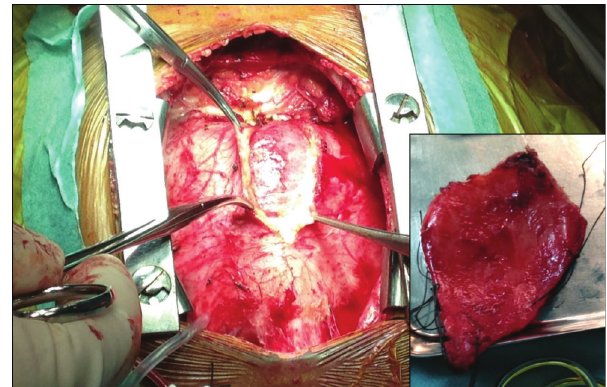
Figure 5: Thickened and adherent pericardium during and imme- diately after